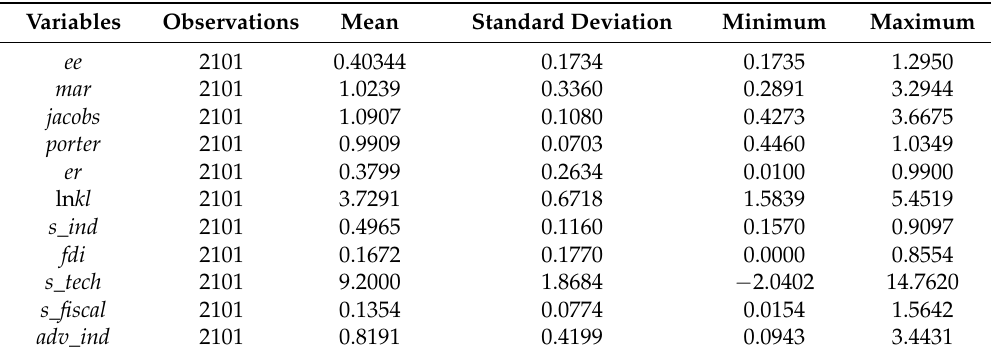
Table 1. Descriptive